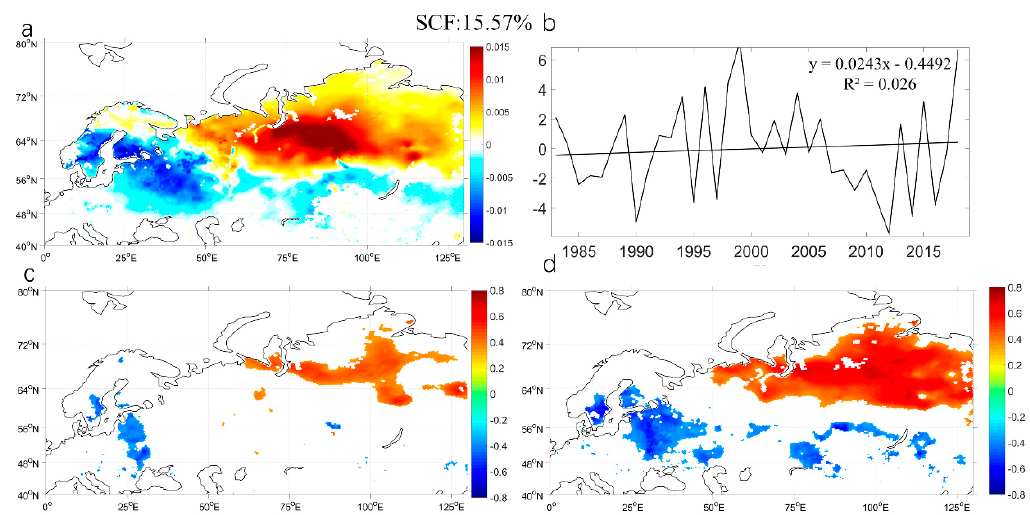
Figure 6. ( a ) Spatial characteristics of the first mode of the empirical orthogonal function on average spring Eurasian snow water equivalent from 1983 to 2018; ( b ) principal component time series of the first mode of the empirical orthogonal function; ( c ) the correlation coefficient distribution between spring snow water equivalent in Eurasia and the Barents–Karas sea ice concentration index; ( d ) the correlation coefficient distribution between spring Eurasian snow water equivalent and the principal component time series of the empirical orthogonal function in winter Eurasian snow water equivalent.